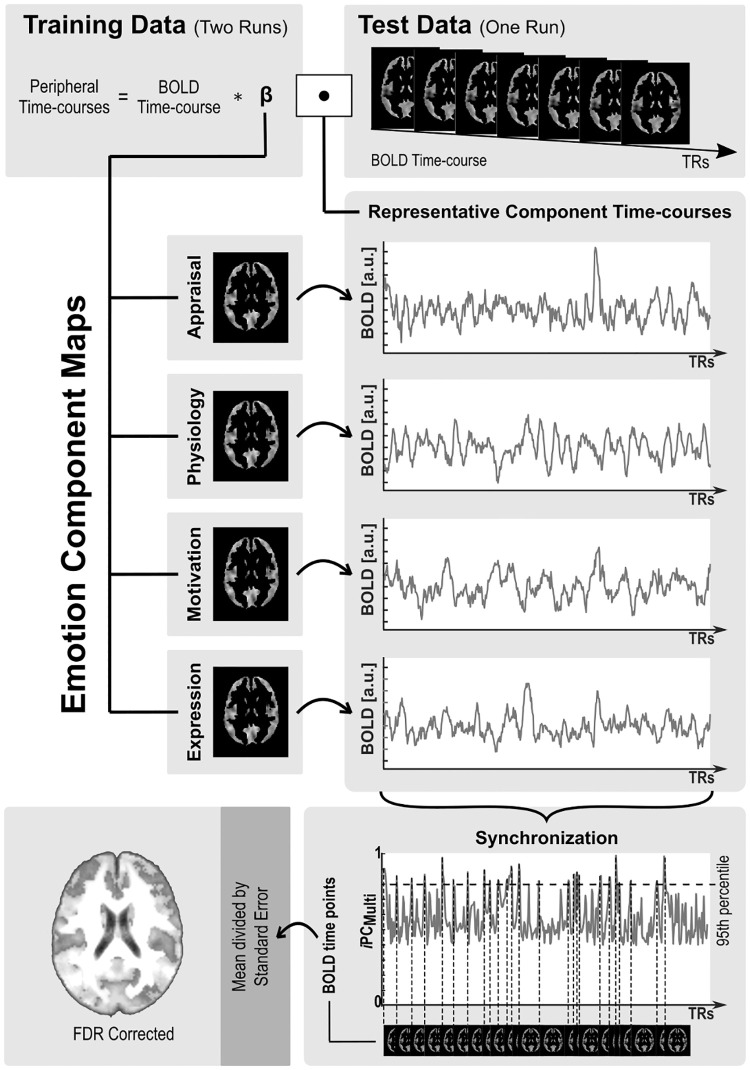
Overview of the analysis pipeline for the brain-based calculation of synchronization between emotion component networks.Representative time courses of emotion component networks were computed from the time point by time point scalar product between the emotion component maps learned for the training set and the BOLD time course of the test set. Synchronization between all 4 representative network time courses was estimated using a multivariate version of the instantaneous phase coherence as a similarity metric. Brain maps of regions selectively activated during high synchronization between all components were obtained by computing z-score across all BOLD volumes that were associated with 5% of the highest synchronization values. a.u., arbitrary units; BOLD, blood oxygenation level dependent; FDR, false discovery rate; iPCMulti, multivariate instantaneous phase coherence; TR, repetition time.